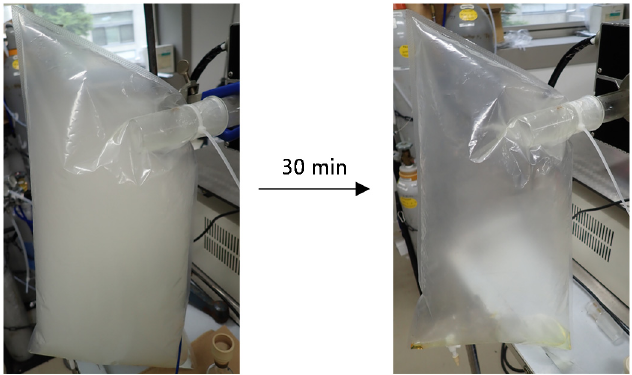
Figure 2. Photographic images of sample bags immediately after pyrolysis and 30 min later. After each trial, the condensates in the sample bag and on the walls of the reactor were extracted with methanol (200 mL), after which the methanol was evaporated under vacuum. A Bruker AC-400 (400 MHz) spectrometer was subsequently used to acquire a 1 H nuclear magnetic resonance (NMR) spectrum of the resulting material in